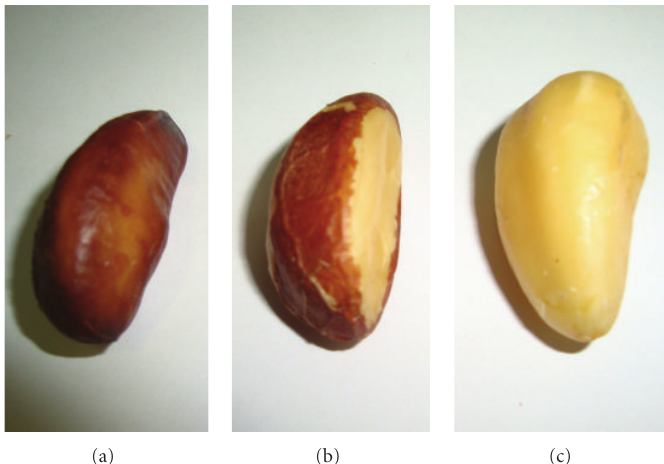
Figure 3: Shelled dry Brazil nuts (a) totally protected by the testae, (b) with some remained testae , and (c) totally cleaned for packaging, showing its sealed nut